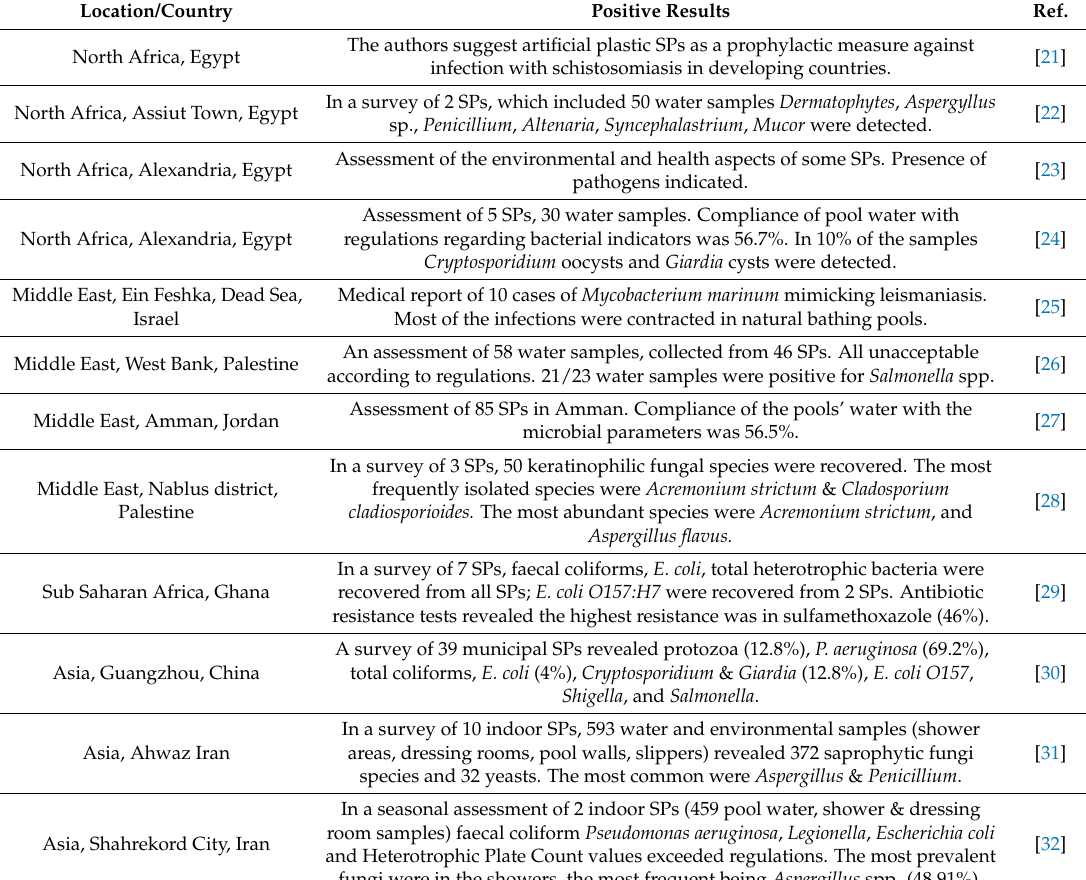
Table 1. Assessments of swimming pools (SPs) located in tropical and subtropical countries. Location/Country Positive Results